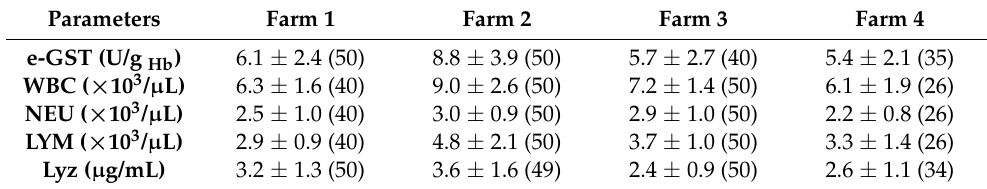
Table 2. Values of e-GST, immune response, and infection biomarkers for the four examined farms.